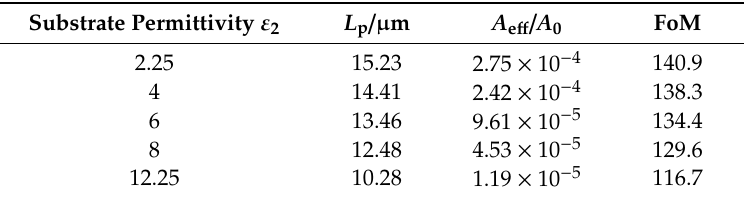
Table 1. Comparison of waveguiding performance with di ff erent substrate